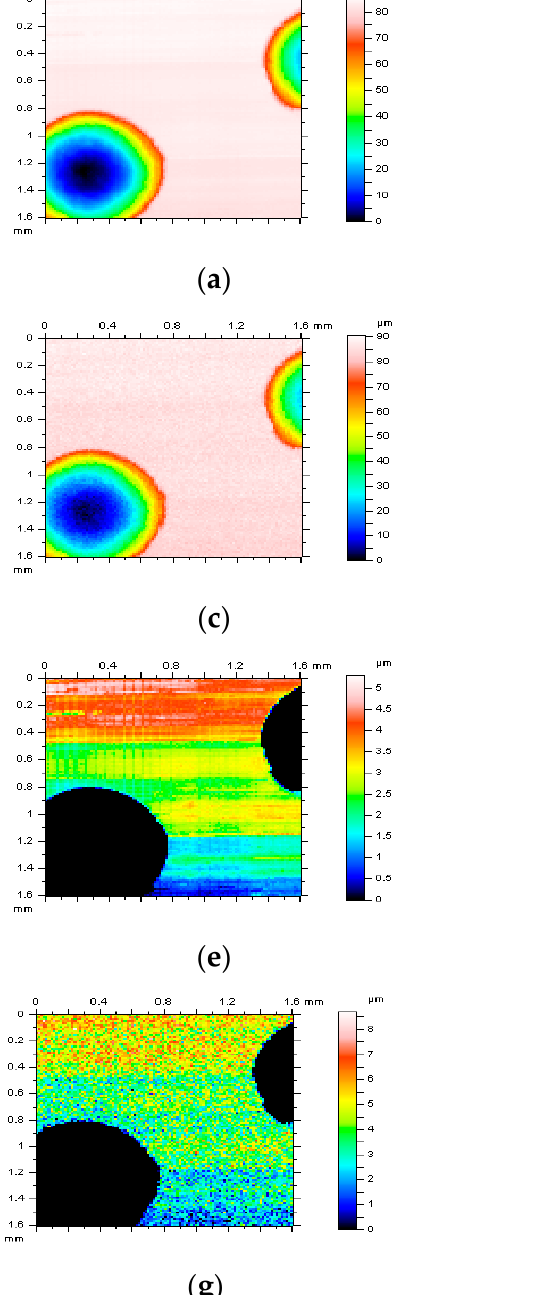
Figure 5. Method of selection of the thresholding value A ( c ) with the Abbott-Firestone curve ( a ) (material ratio curve ( b )) for plateau-honed cylinder liner surface containing dimples, the approach is based on the Sk and Svk parameter descrip- tions.